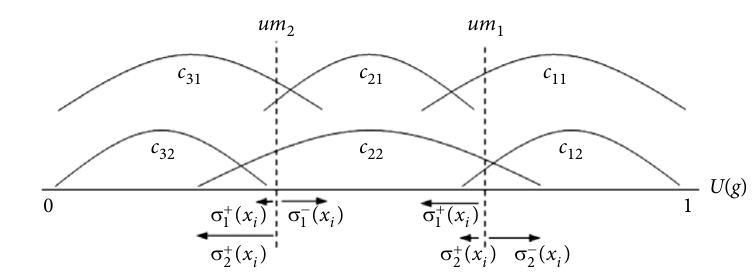
Fig. 6. Representation of misclassification errors multiple classification